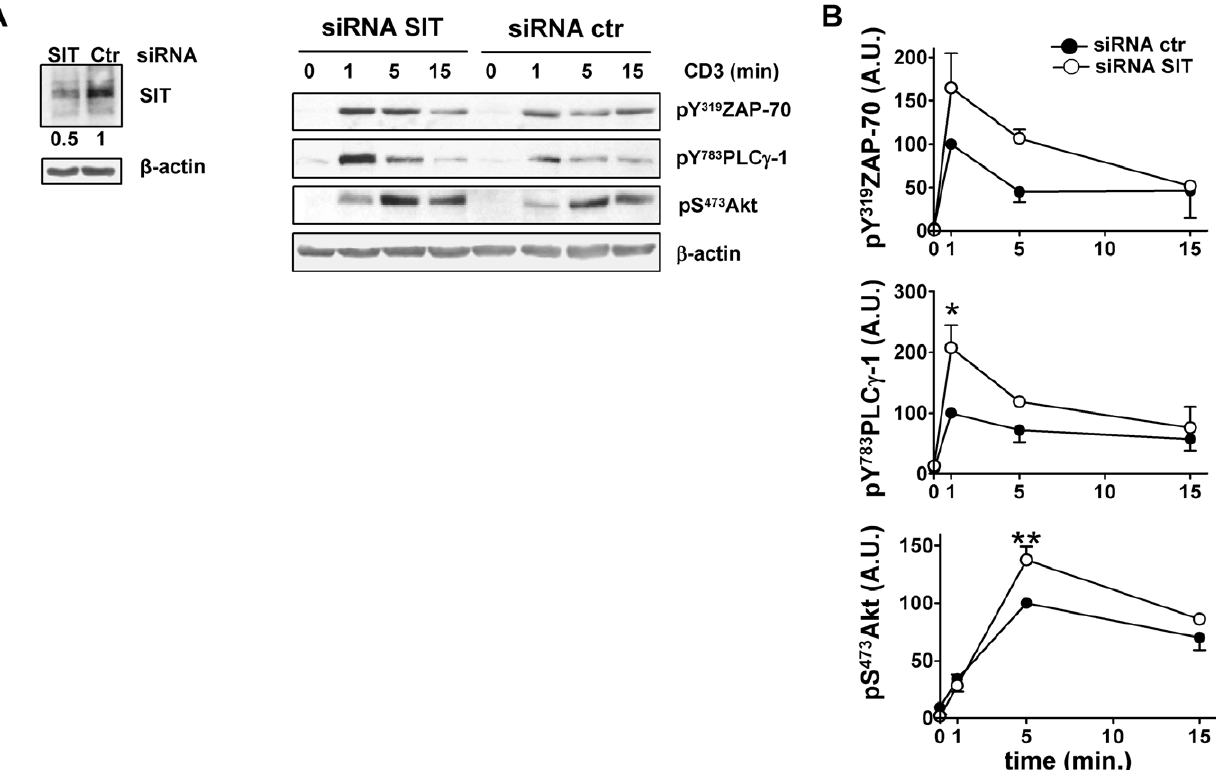
Figure 2. Downregulation of SIT results in an enhanced TCR-mediated signaling in primary human T cells. A) Primary human T cells were transfected with control or SIT-specific siRNA and 72 h later were stimulated with non-crosslinked CD3 (clone OKT3) mAb for the indicated times. Cell lysates were analyzed by immunoblotting using phosphospecific antibodies for ZAP-70, PLC c -1, and Akt. Immunoblots verifying SIT downregulation are shown. B) Phosphorylated bands were quantified using the ImageQuant software and values were normalized to the corresponding b -actin signal. Graphs show the phosphorylation levels of ZAP-70, PLC c -1, and Akt shown as of arbitrary units 6 SEM of 2, 4, and 6 independent experiments, respectively. Statistical significance in B) * p , 0.05 and **p , 0.01.